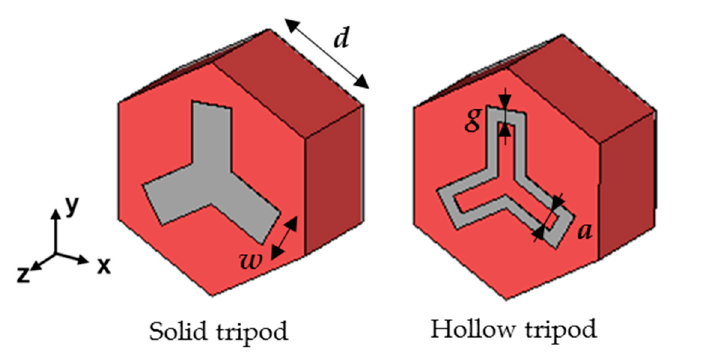
Figure 1. Front view of the designed tripod metasurfaces unit cells. Metallization is represented in grey and polypropylene (PP) substrate in red.